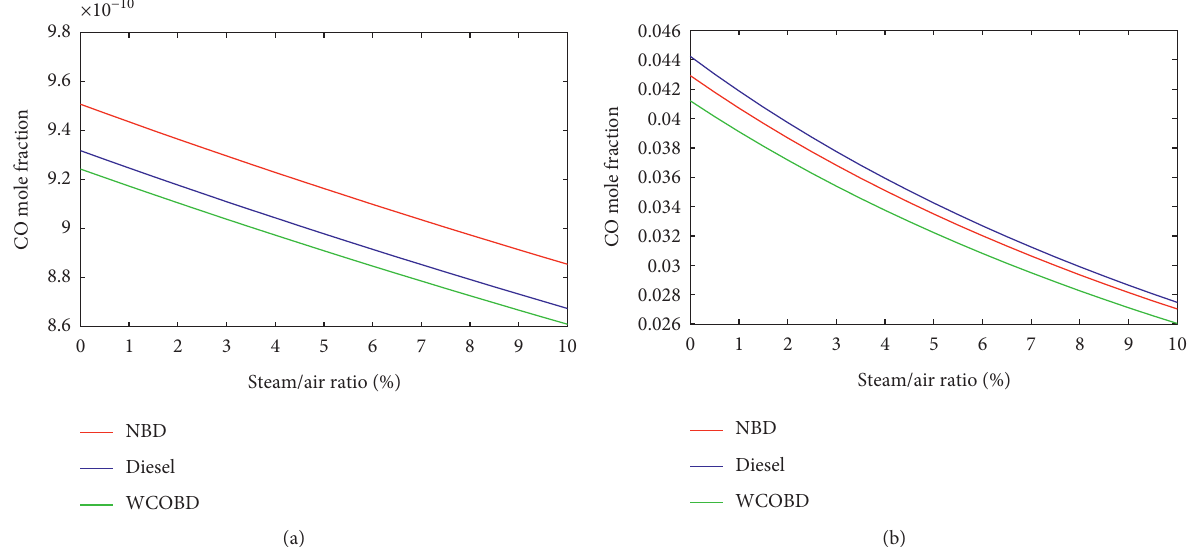
Figure 5: Variation of CO equilibrium mole fractions with steam injection ratios.